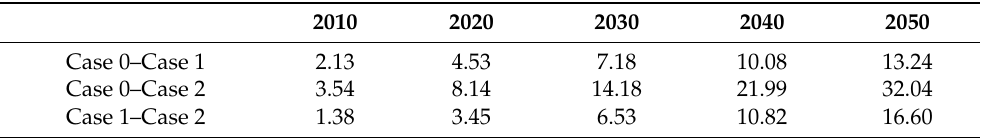
Table 5. Percentages of the increase in adjusted GDP as a result of the actions carried out in each simulation